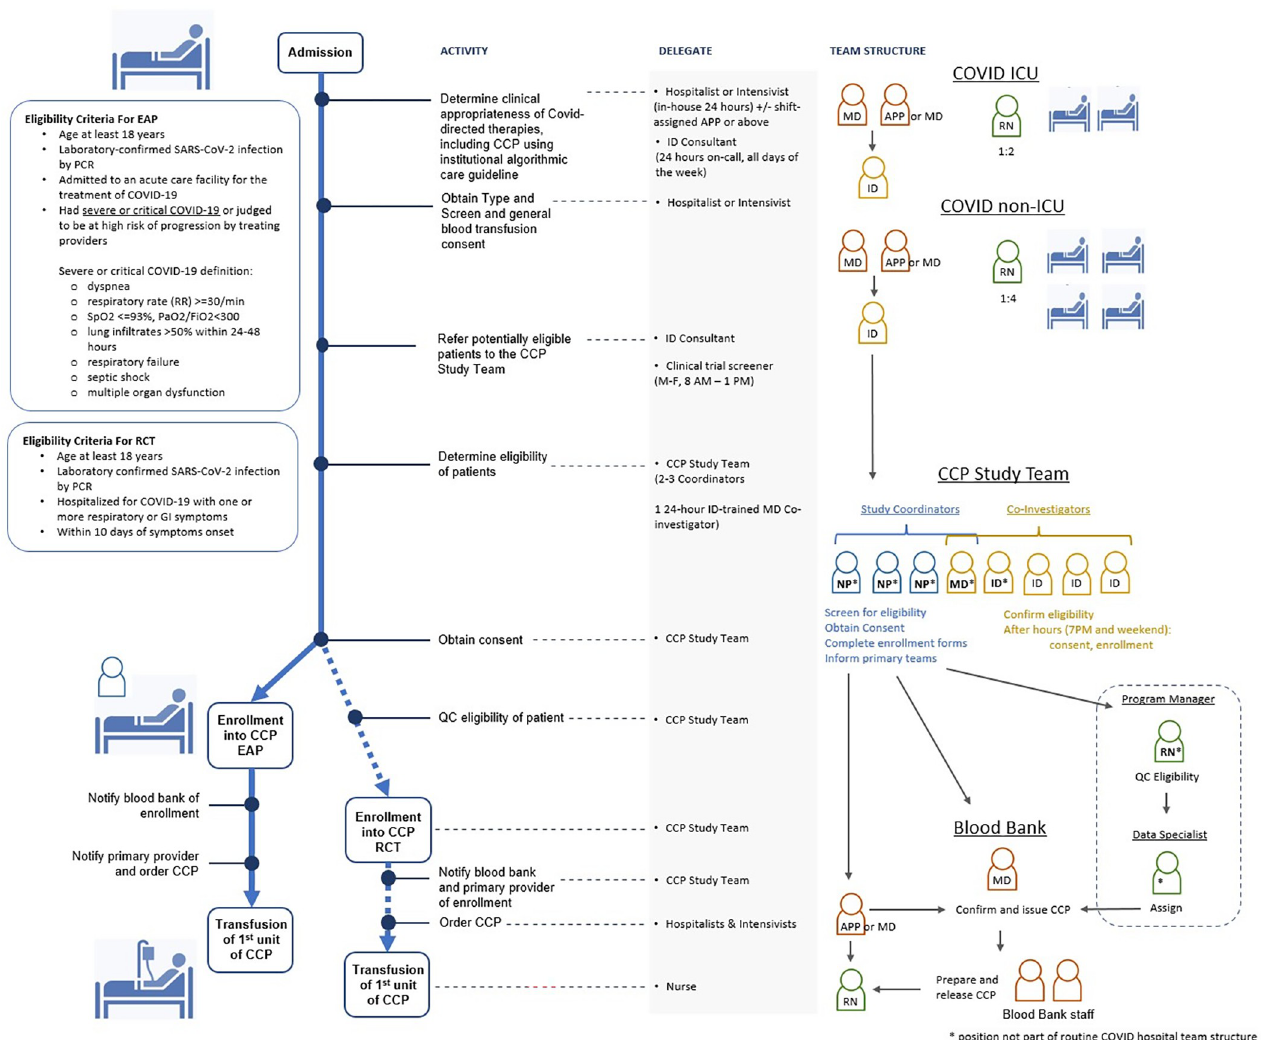
Fig 1. CCP administration process schematic. Steps, eligibility criteria, and personnel involved in administering COVID-19 Convalescent Plasma (CCP) in the inpatient setting at The University of North Carolina Medical Center (UNCMC). The major process events of admission, enrollment, and infusion depicted in Fig 1 are scaled proportionally to the median time intervals spent on these activities at UNCMC. EAP = expanded access program, PCR = polymerase chain reaction, RCT = randomized controlled trial, GI = gastrointestinal, ICU = intensive care unit, ID = infectious diseases, MD = medical doctor, APP = advanced practice provider, RN = registered nurse, NP = nurse practitioner, QC = quality